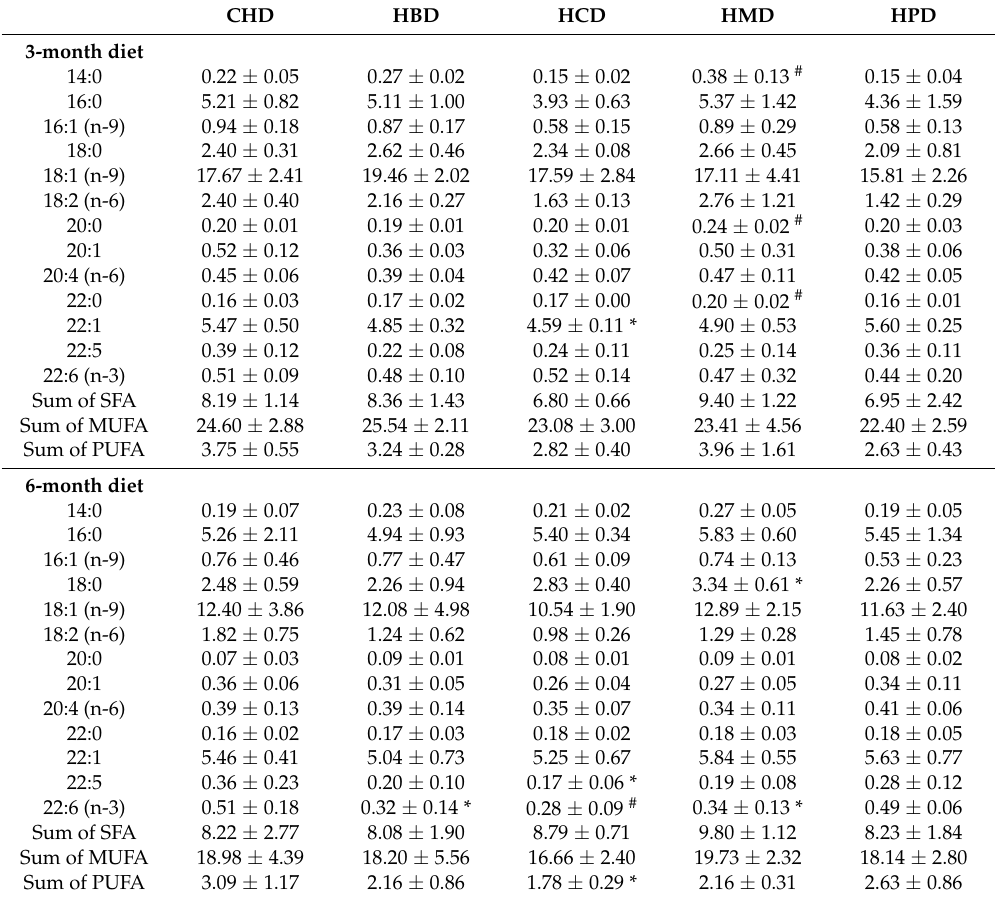
Table 2. Fatty acid profile of neutral lipids in hearts of mice fed different high-fat diets 1